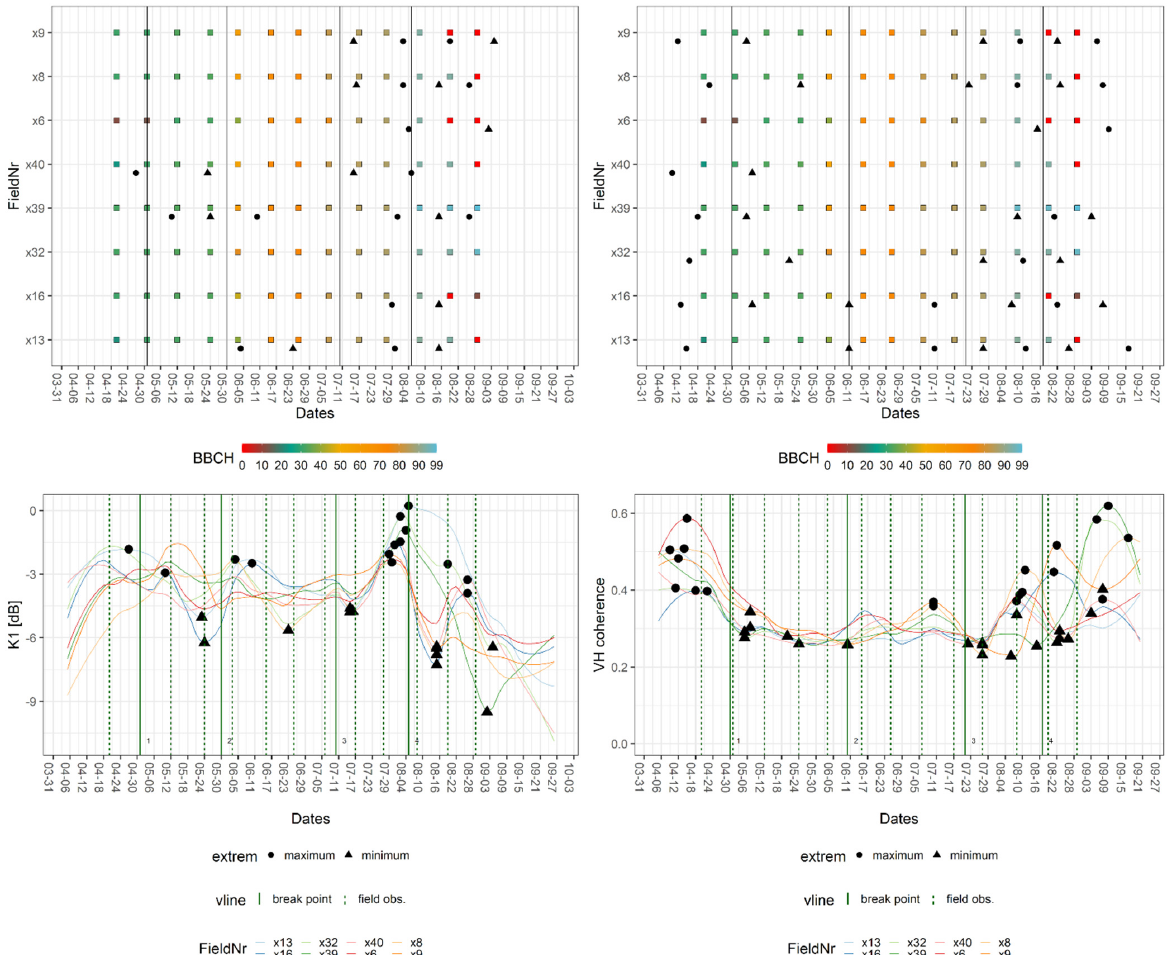
Figure 6. Exemplary breakpoint and extreme value analysis for K1 and VH coherence signatures of fields of wheat. Upper part: BBCH progression of in situ measurements per field with dates of breakpoints (vertical line = breakpoint) and relevant extrema (extreme). Lower part: crop signatures with breakpoints and relevant extrema as well as dates of closest field observations (vertical line = field obs.).